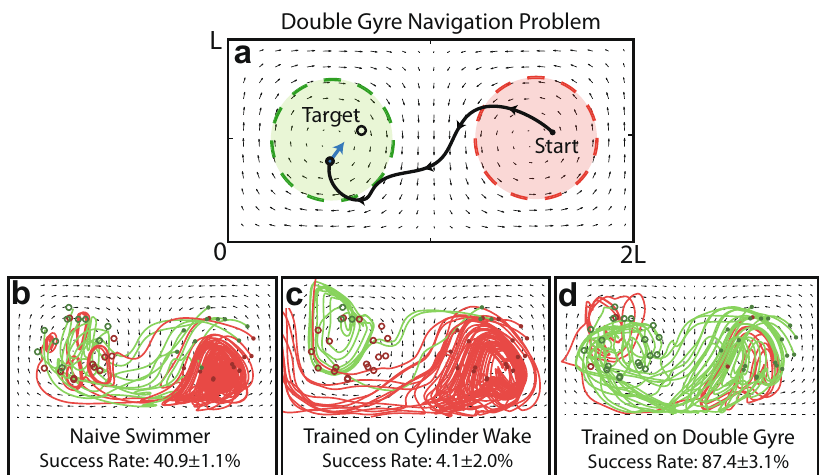
Fig. 7 RL navigation in the double gyre fl ow fi eld. a Navigation problem setup. The start and target regions are L /2 in diameter and located at (3 L /2, L /2) and ( L /2, L /2), respectively. b A naive policy achieves 40.9% success rate on average. c The velocity RL swimmer trained on the cylinder wake navigates the double gyre fl ow poorly, indicating its navigation policy did not generalize. d After receiving training for the double gyre fl ow, the velocity RL swimmer is able to adapt and navigate more effectively than either swimmer. As with the cylinder fl ow, successful attempts to reach the target are green, while unsuccessful attempts are red. An episode is successful when a swimmer reaches within a radius of L /50 around the target location. The stated success rates are averaged over 12,500 episodes and are shown with one standard deviation arising from the fi ve times each swimmer was